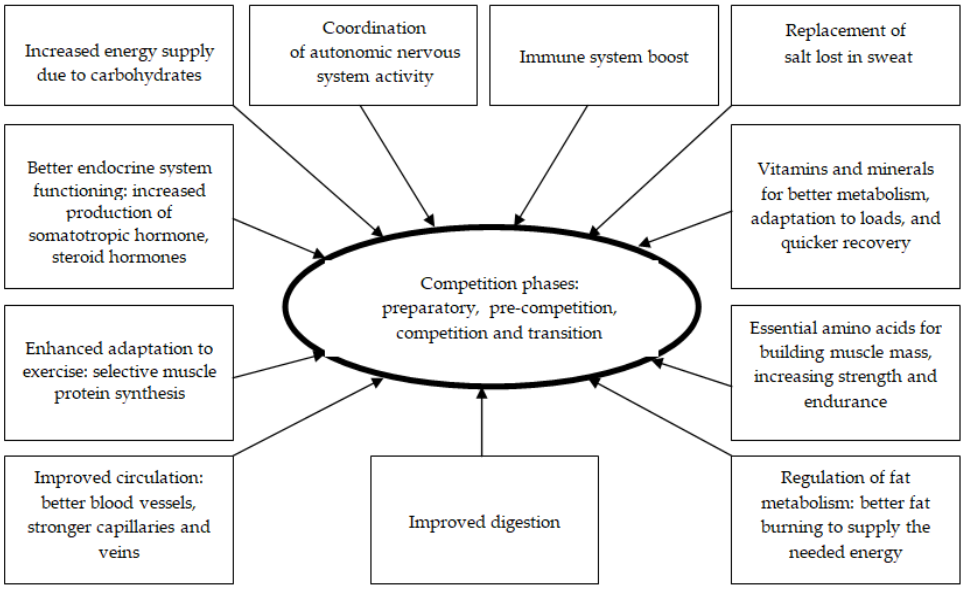
Figure 3. The benefits of adding dietary supplements to the eating plans of sportsmen.